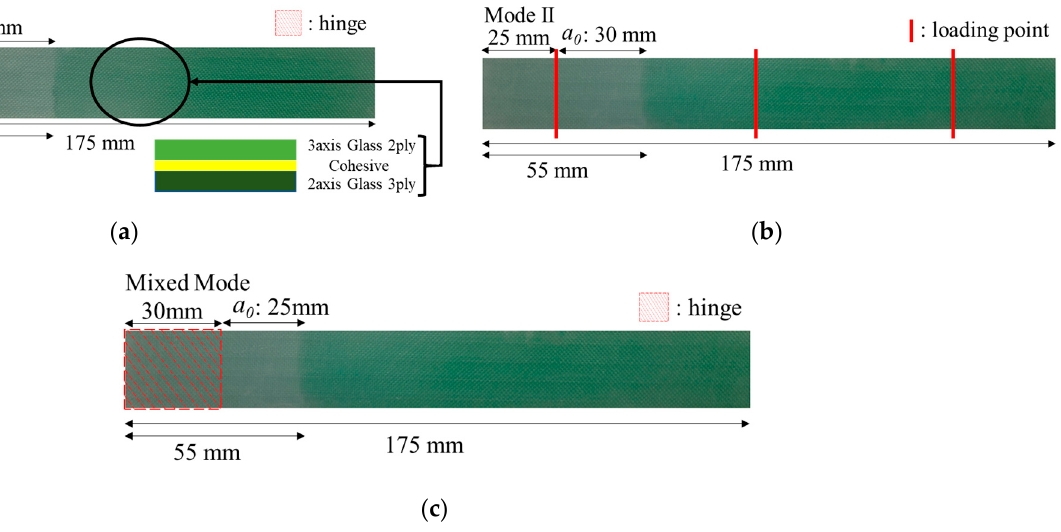
Figure 1. Test specimen dimension: ( a ) DCB (Mode I), ( b ) ENF (Mode II), and ( c ) MMB (Mixed-